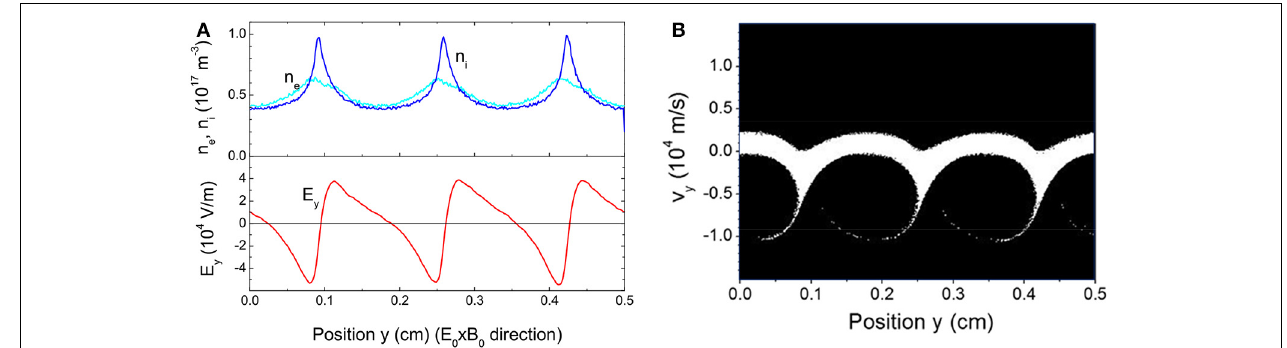
10 20 m − 3 (0.005torr at 300K). The length of the acceleration region is L x = 1cm. The instability is saturated by electron-neutral collisions and by the finite acceleration length, and steady state is reached in about 1 μ s; (B) Phase diagram (v y , y) of the ions along the azimuthal direction showing ion trapping in the wave potential and Landau absorption (conditions of Figure 13A ). The ions are collisionless and unmagnetized in this